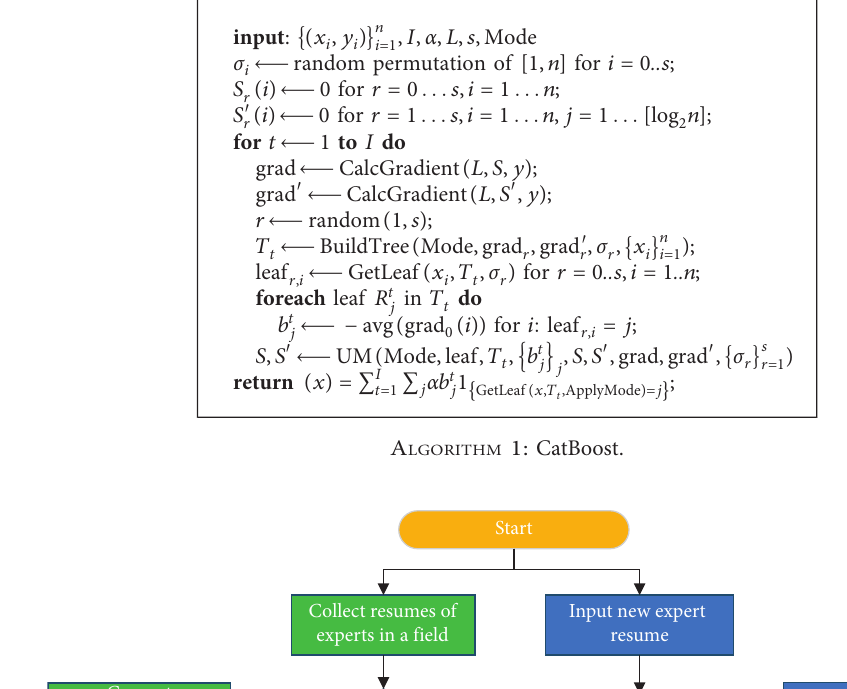
minimum size of samples in the classifier training, the existing data set is expanded. The Monte Carlo simulation